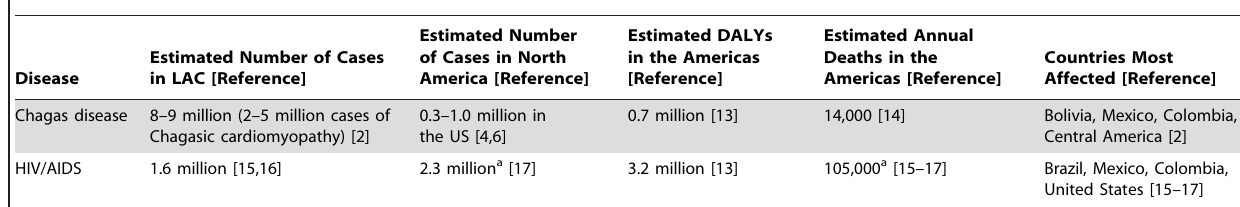
Table 1. Comparison of Chagas disease versus HIV/AIDS.